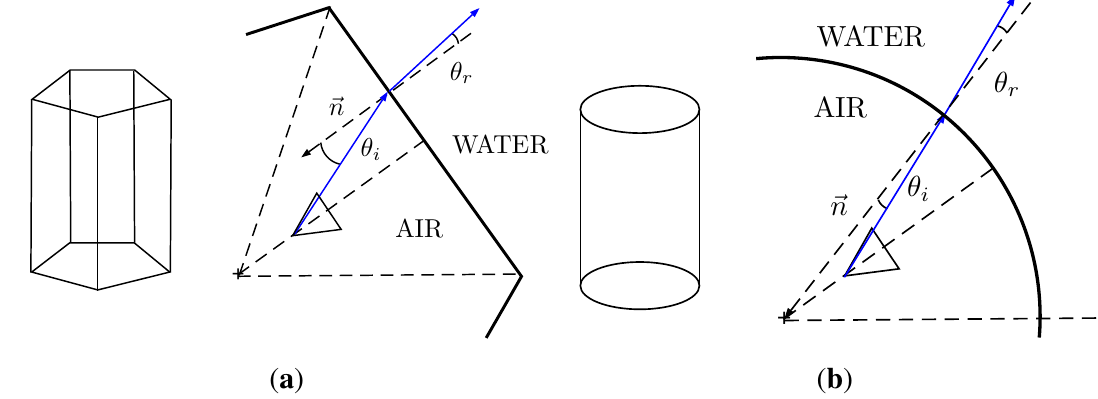
Figure 4. Comparison between a pentagonal prism and a cylinder as view-port options for the lateral cameras. When compared with the flat view-ports of the pentagonal prism, the cylinder has the advantage of being less affected by the refractions of the media transitions, along one of the directions. ( a ) Pentagonal prism shape; ( b ) cylindrical